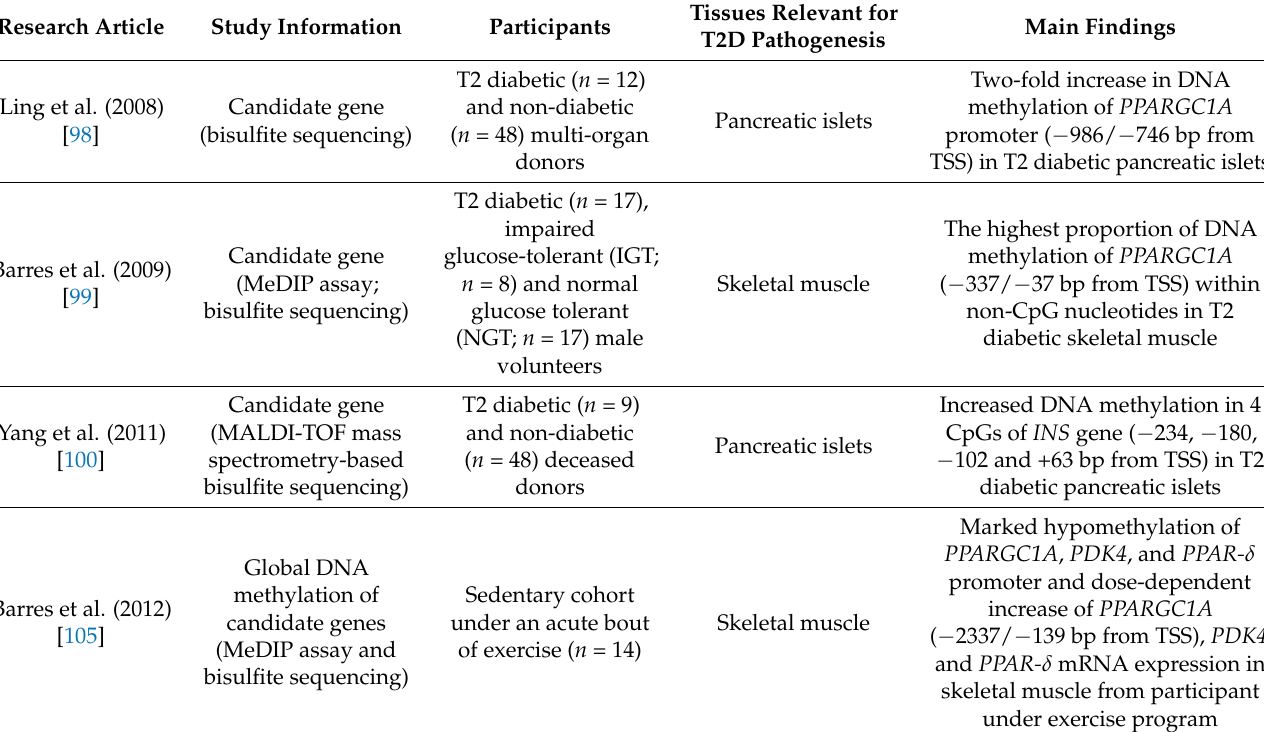
Table 1. Methylation studies in pancreatic islets and insulin-target